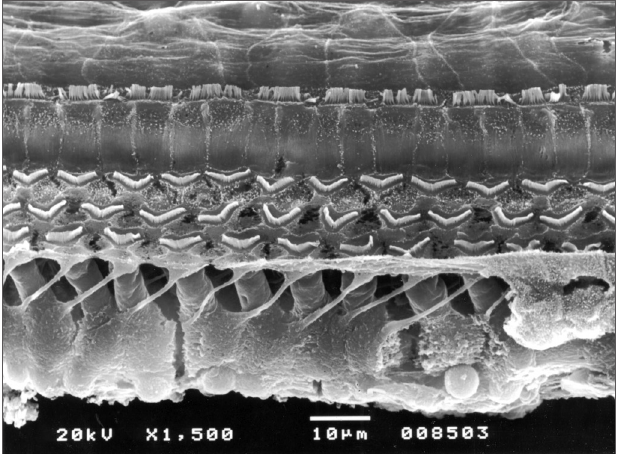
Figure 3. Cochlea basal ramp belonging to an animal from the oto- silicate group after 90 days. Inner and outer hair cells without lesion.